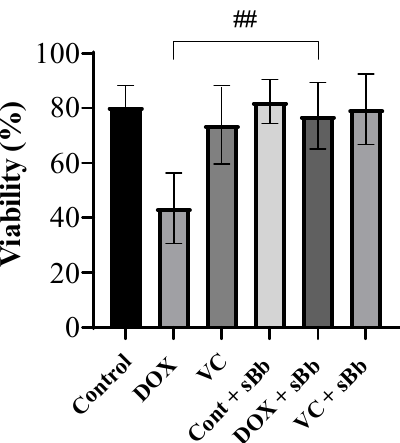
Figure 2. sBb increases the viability of DCs treated with DOX. The DCs were treated with 0.25 µ g/mL DOX, 0.25 µ g/mL VC and 0.1 µ g/mL sBb for 2 days, then trypan blue exclusion assay was performed. The number of viable and dead cells were counted, and the viability rate was calculated. ## indicates p < 0.01 compared to the viability of DCs in the absence or presence of sBb.